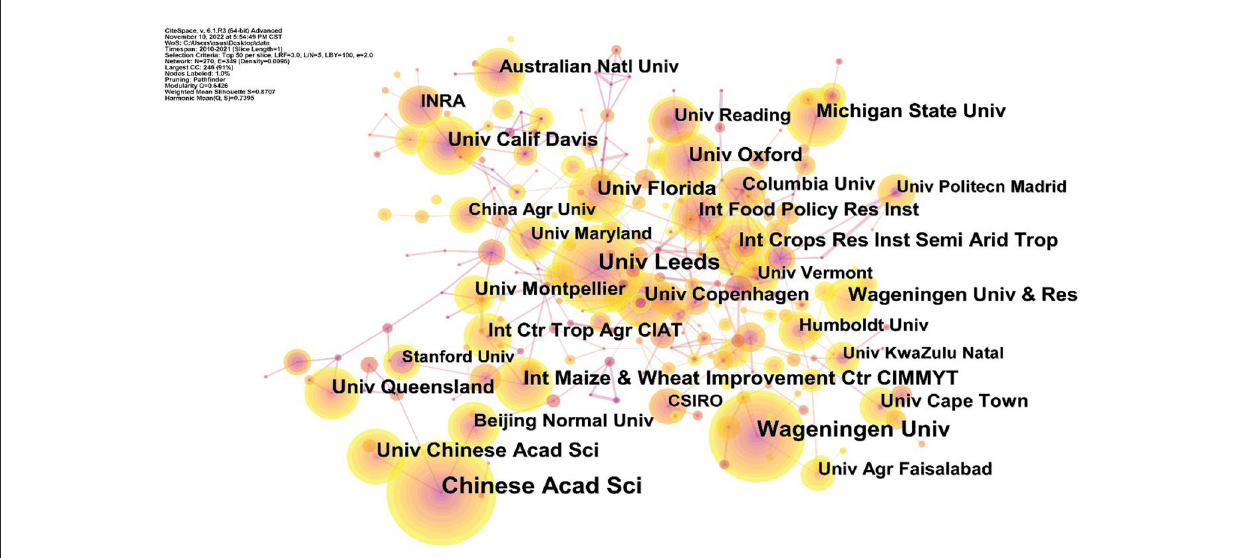
FIGURE4 A visualization of the institution cooperation network. Each node represent a institution, the larger the node, the more publication that institution has. The line represent the connection between insitutions, the thicker the line, the closer relationship and the lighter color of the line, the later connection.